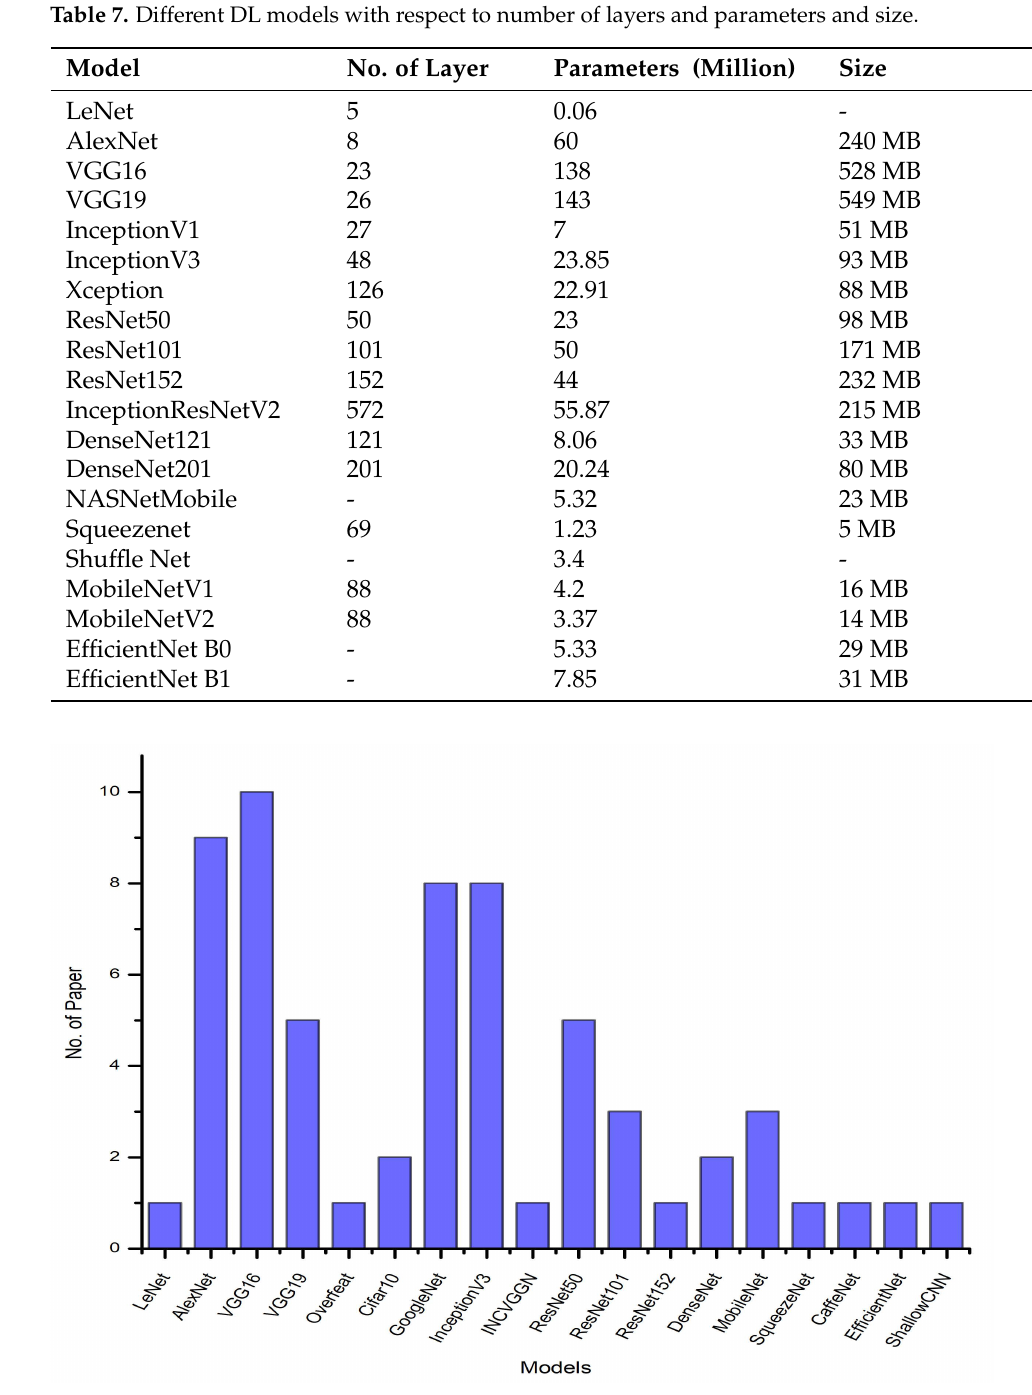
Figure 3. Number of research papers for various deep learning